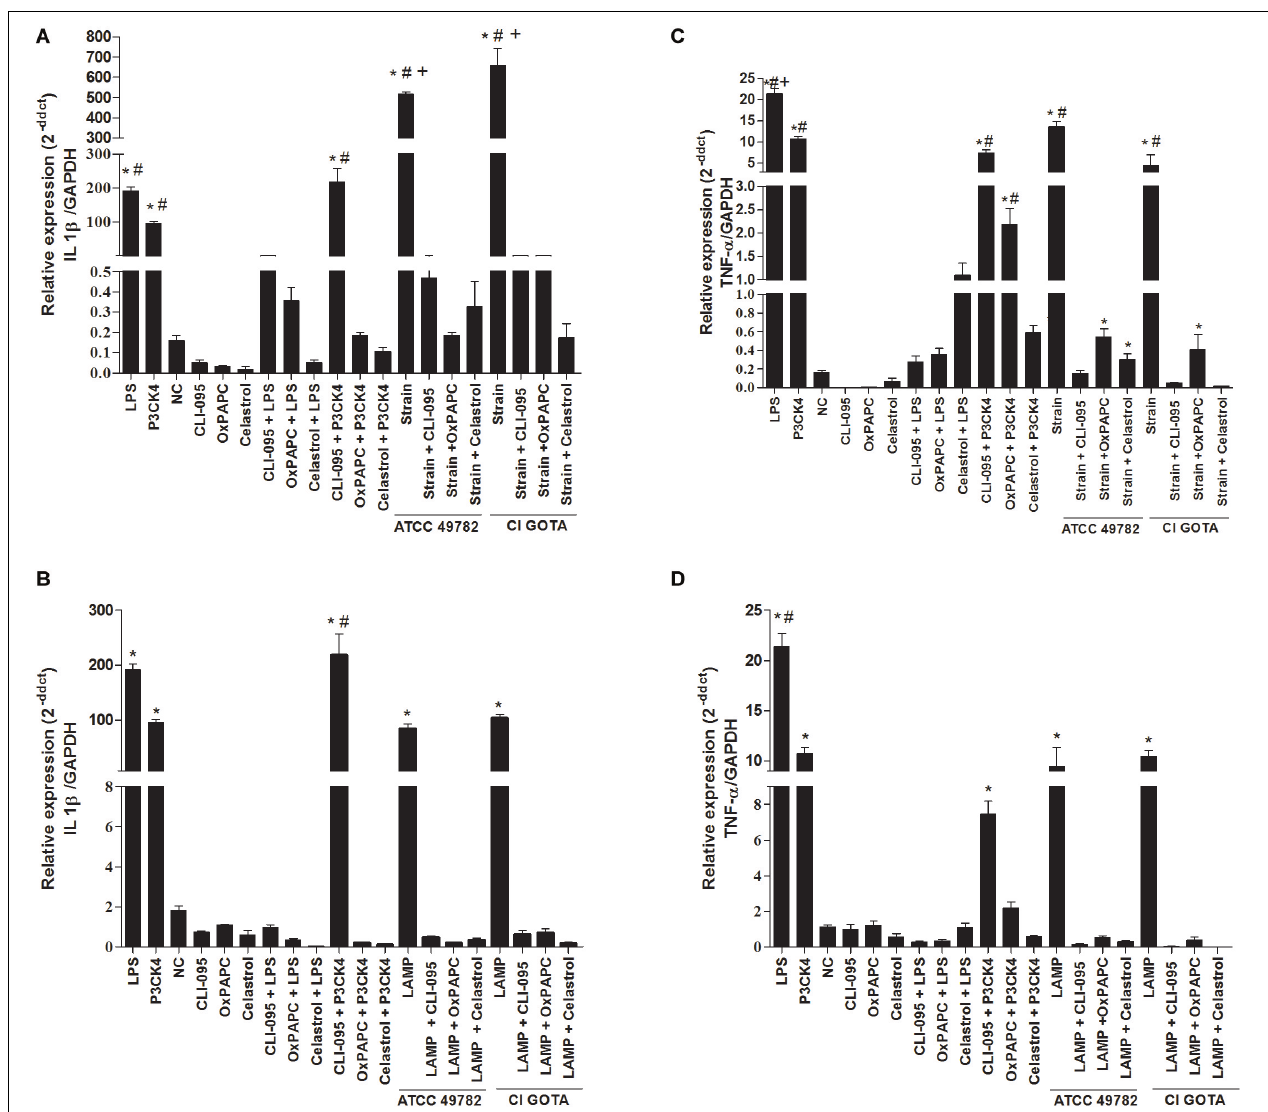
FIGURE 5 | Gene expression of IL-1 β and TNF- α from bovine macrophages exposed to U. diversum and LAMPsUd and pretreated with signaling blockers for TLR4 (CLI-095), TLR2/4 (OxPAPC), and NF- κ B (Celastrol). The cells were analyzed after 2 h (LAMPs) and after 12 h ( U. diversum ). (A) Expression of IL-1 β after incubation with ATCC 49782 (10 5 Ureaplasma /mL) and CI-GOTA (10 3 Ureaplasma /mL). (B) Expression of IL-1 β after incubation with LAMPsUd of ATCC 49782 and CI-GOTA (2 µ g/ml). (C) Expression of TNF- α after incubation with ATCC 49782 (10 5 Ureaplasma /mL) and CI-GOTA (10 3 Ureaplasma /mL). (D) Expression of TNF- α after LAMPsUd incubation of ATCC 49782 and CI-GOTA (2 µ g/ml). The treatments were compared with positive control (inoculation of U. diversum or LAMPsUd in the absence of blocker: W/B). PBS was used as negative control (CN) and 100 ng/mL of LPS and 100 ug of Pam3CysSK4 was used as positive control. Treatments were compared using the Kruskal–Wallis non-parametric test followed by the Dunn post-test. Statistically different groups are those presenting different symbols. Statistical significance ( p < 0.05) is represented by the symbols ( ∗ difference with groups with blockers, # difference with the NC group, and + difference among strains). Data are expressed as mean ± standard deviation ( n =